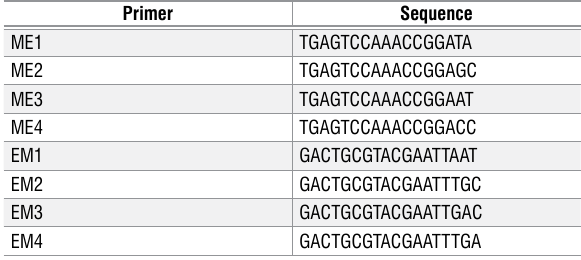
Primer sequences tested